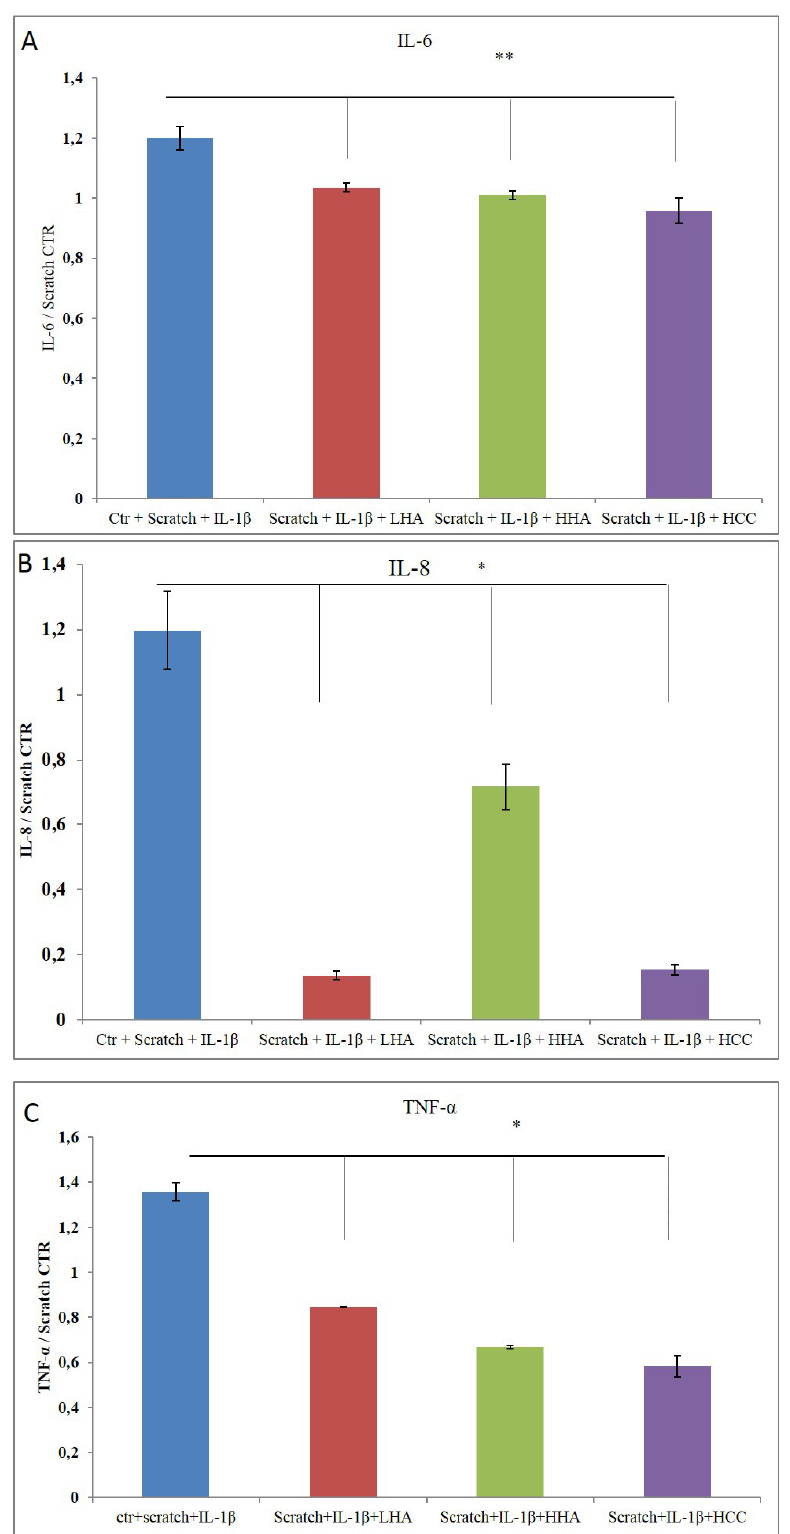
Figure 8. Quantification of cytokines. ( A ) TNF- α , ( B ) IL-6, and ( C ) IL-8 were evaluated using Bio-plex. The data were normalized with respect to the scratch control (CTR) and reported as ratios of protein concentration (pg / mL) as mean ± SD. * p < 0.01 for HCC, HHA, and LHA vs. CTR in ( A ); p < 0.05 for HCC vs. CTR in ( B ); or p < 0.01 for HCC, HHA, and LHA vs. CTR in ( C